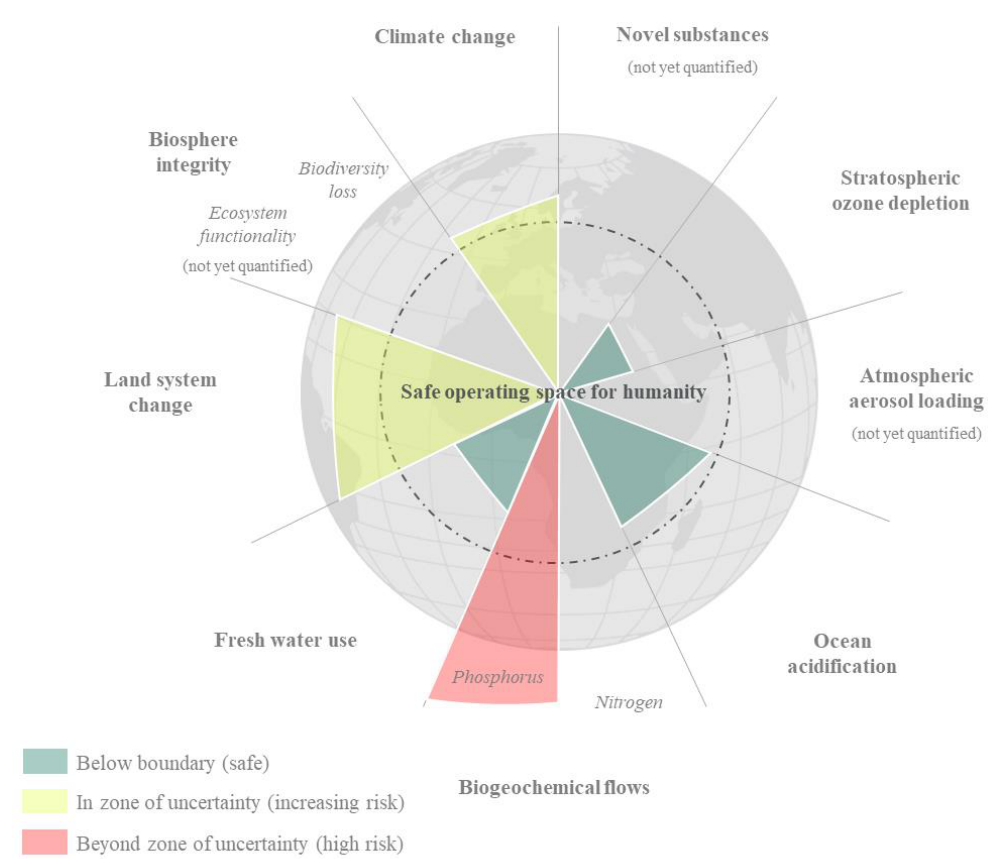
Figure 1. Concept of planetary boundaries according to Rockström et al. [18].